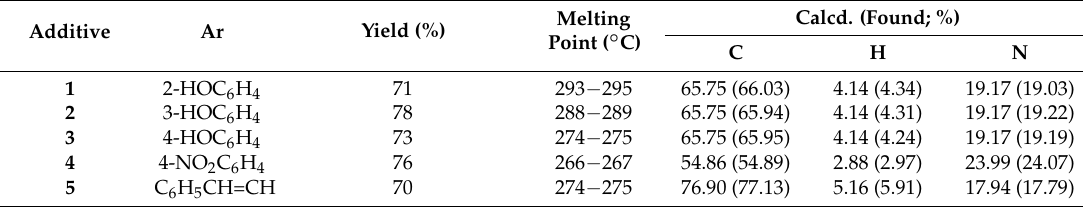
Table 1. Elemental analyses and some physical properties for Schiff bases 1 − 5 .